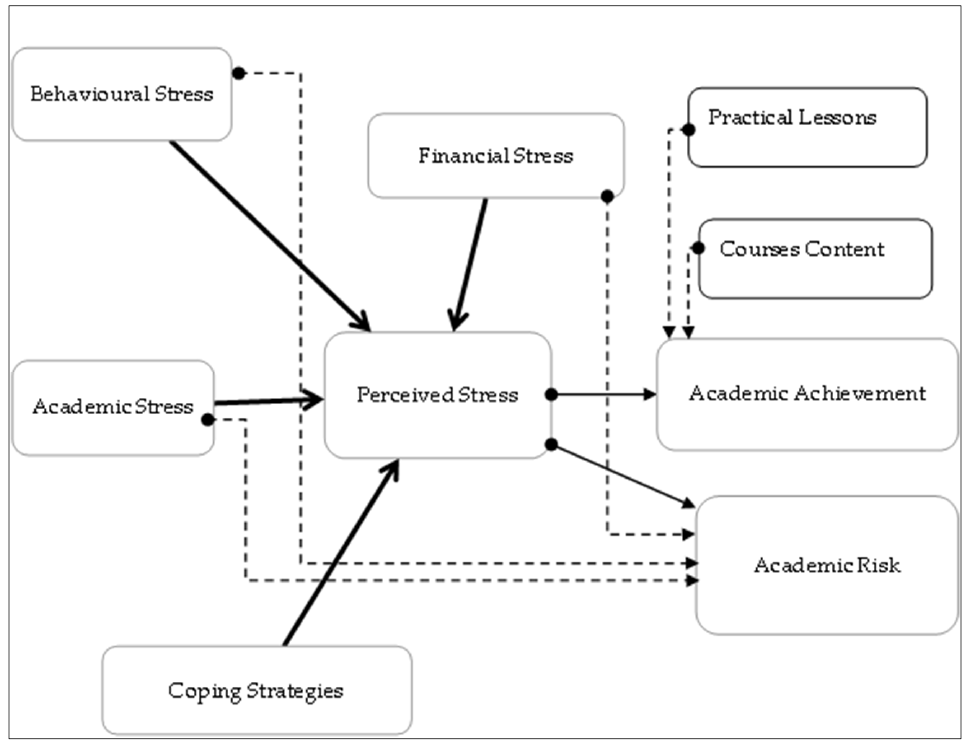
Figure 1. The theoretical structural model .